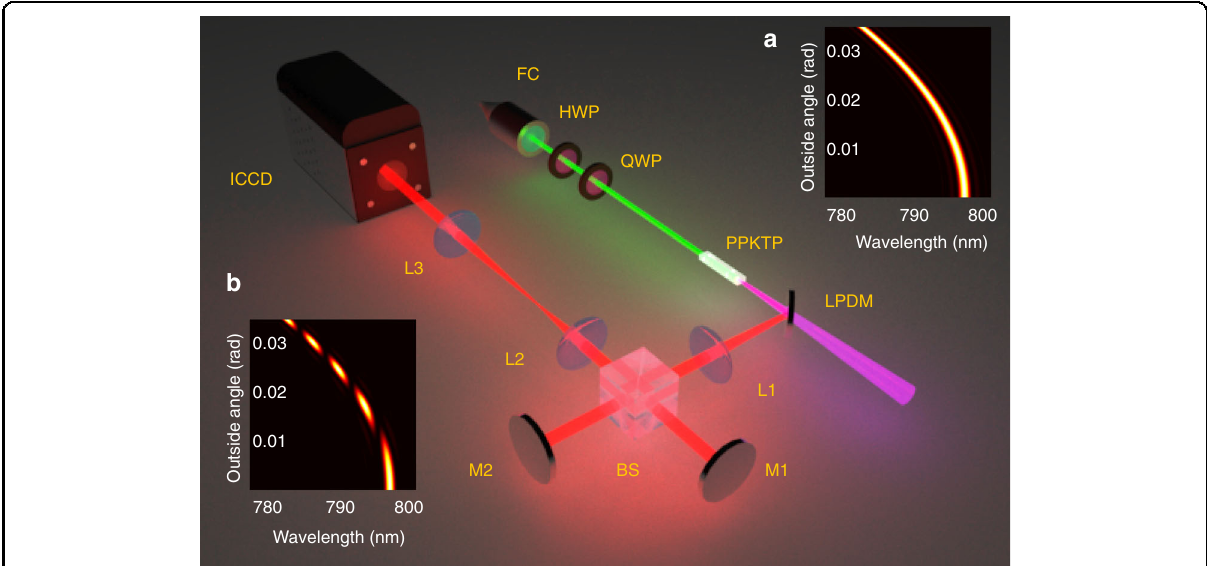
Fig. 2 Schematic of the interferometer. The focal lengths of lens L1 – L3 are 100 mm, 100 mm, and 200 mm. M1, M2: mirrors; BS: beam splitter; LPDM: long-pass dichroism mirror; FC: fi bre collimator; HWP and QWP are half waveplate and quarter waveplate; PPKTP: periodically poled potassium titanyl phosphate; ICCD: intensi fi ed charge-coupled device. Insets: frequency-angular spectrum of a the signal photons outside the crystal and b after the interferometer and lens L2. The frequency-angular spectrums in ( a ) and ( b ) are obtained by simulation using equations (S4) and (S5) in the Supplementary Information,